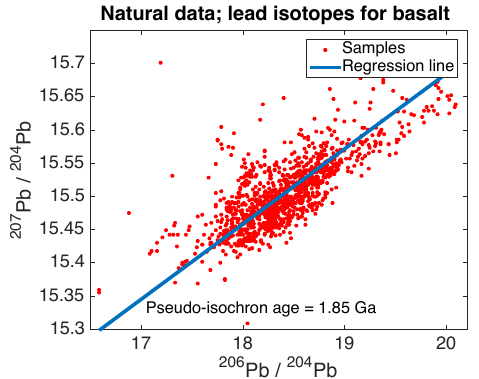
Figure 8. Scatter plot of measured ratios of Pb isotope data of mid- ocean ridge basalt (MORB) samples (data from the PetDB database: Lehnert et al., 2000, www.earthchem.org/petdb). The data selected are for “spreading ridges”, “basalt”, and “fresh”; samples were taken deeper than 2000m below sea level. The geometric mean re- gression line has a pseudo-isochron age of